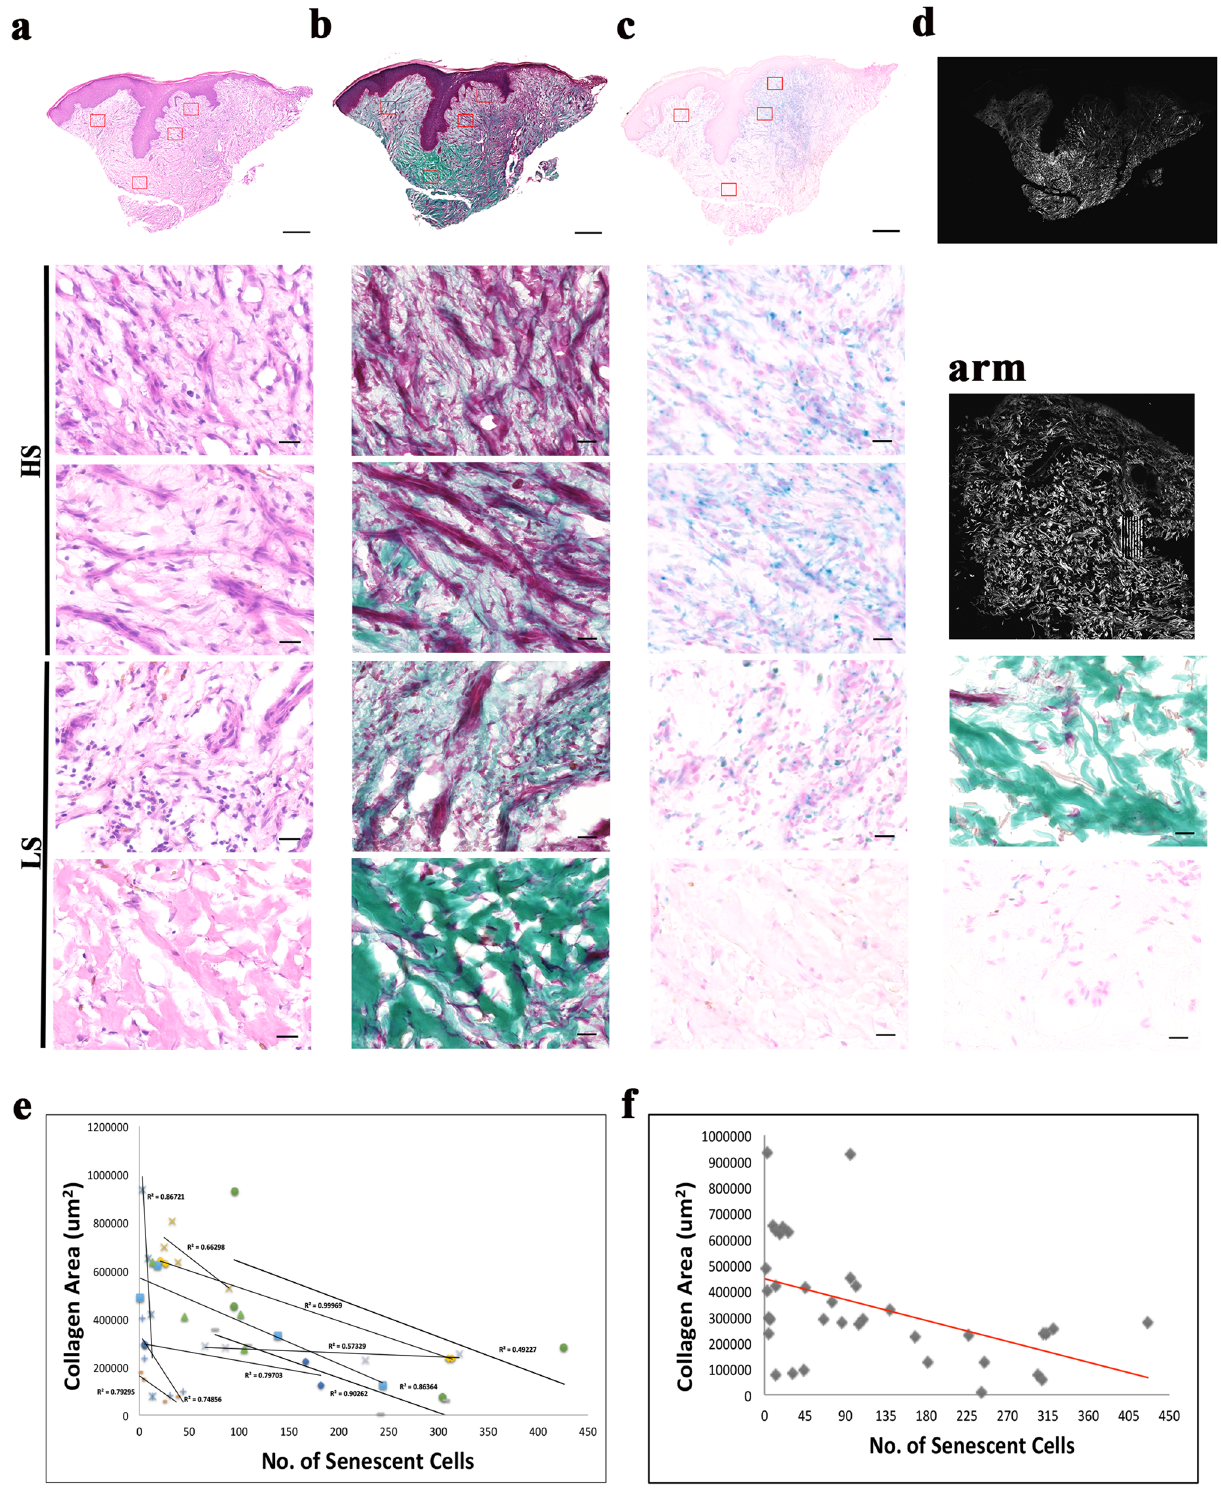
Figure 1. Staining of nuclei, collagen and senescent cells of venous leg ulcer biopsies revealed a strong link between presence of senescent cells and collagen area. ( a ) Haematoxylin and eosin staining of nuclei (purple) and extracellular proteins (pink) in a venous leg ulcer. Montage of high-power images [1200 (W) × 1000 (H) μm] of an 8 μM cryosection thick—two from high senescence (HS) regions and two from low senescence (LS) regions of a venous leg ulcer taken using × 20 objective lens. ( b ) MT staining collagen (green), muscle and keratin (red) and cytoplasm (pink/red) in a sister section. Montage followed by ( c ) X-gal staining as a marker for senescent cells (senescent cells (blue), nuclei and cytoplasm (pink). Scale bar: 500 μm (montage) and 20 μm (high power). ( d ) SHG imaging of collagen (white) in × 20 for VLU and arm tissue. Scale bar: 200 μm. MT and X-gal images of the arm tissue are also shown. ( e ) Regression plots of collagen area (x-axis) against senescent cell number (y-axis) of individual patients of the VLU cohort. ( f ) Single regression plot of the VLU